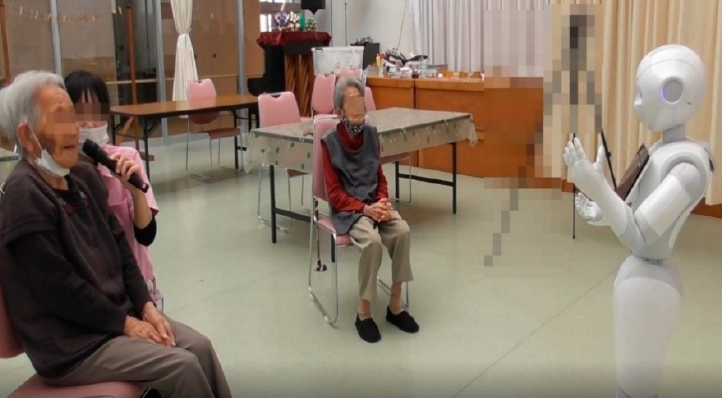
Figure 4. Subjects A and B, who were women in their 90s with Alzheimer’s disease.